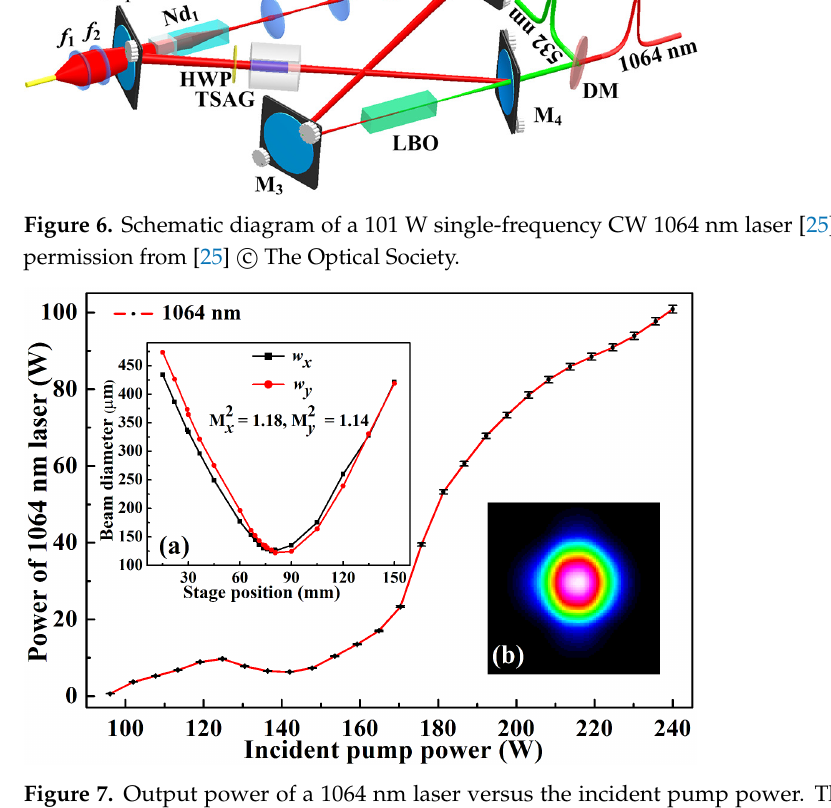
Figure 7. Output power of a 1064 nm laser versus the incident pump power. The insets were ( a ) the beam quality factor and ( b ) the profile of a 1064 nm laser at the maximum output power [25]. Reprinted with permission from [25] c (cid:13) The Optical